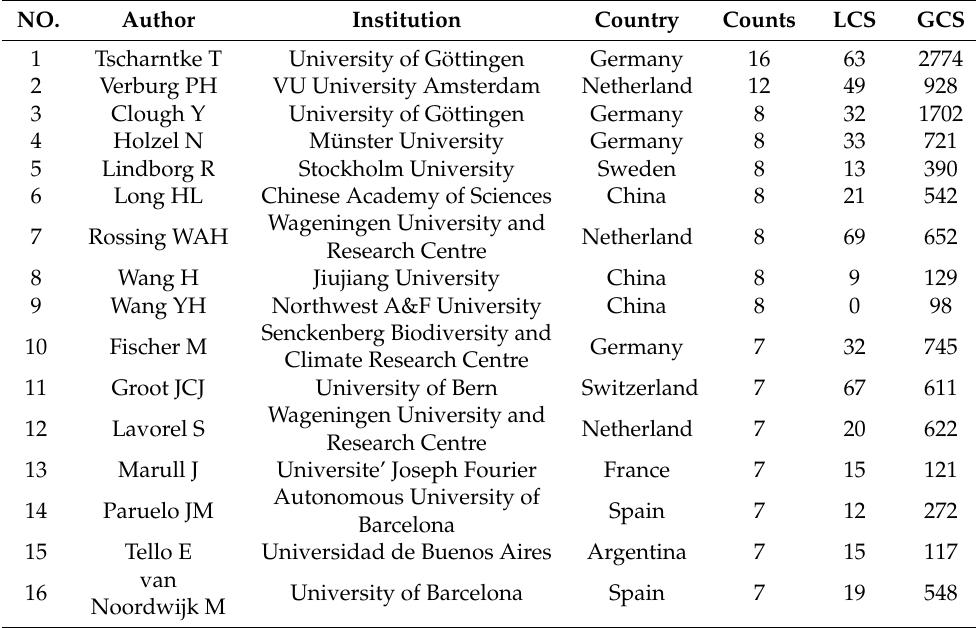
Table 2. Authors with more than seven publications on agricultural land function.